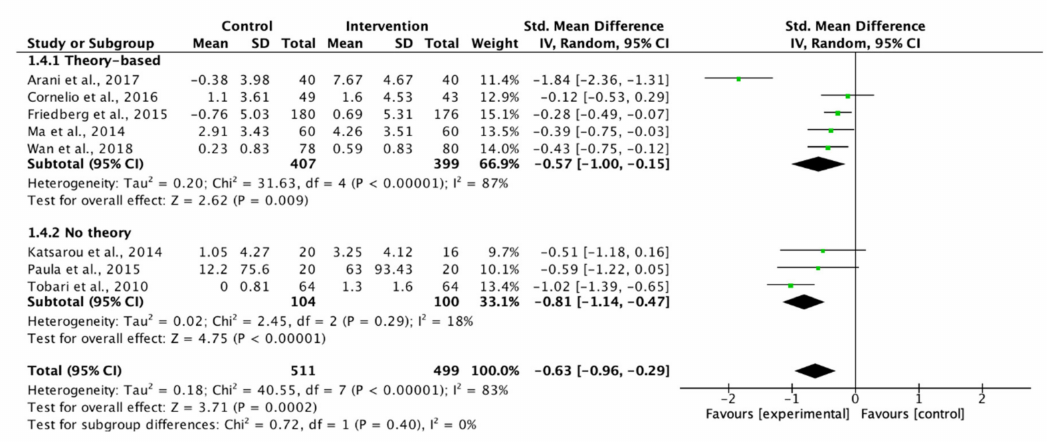
Figure 5. Forest plot of theory-based interventions on adherence to dietary